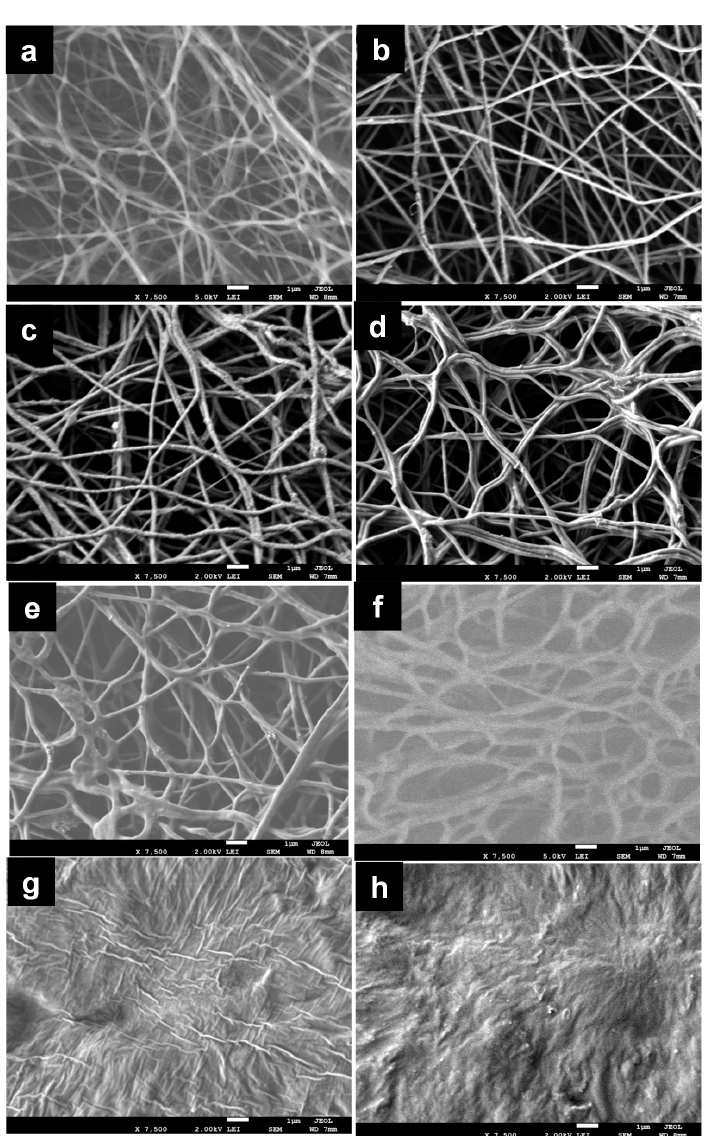
Figure 3. SEM micrograph of pure sol–gel fiber ( a ) and hybrid fibers in which the volume ratios of CL sol–gel solution and PGS solution were 99/1 ( b ); 95/5 ( c ), 90/10 ( d ); 85/15 ( e ); 80/20 ( f ); 70/30 ( g ); and 50/50 ( h ).